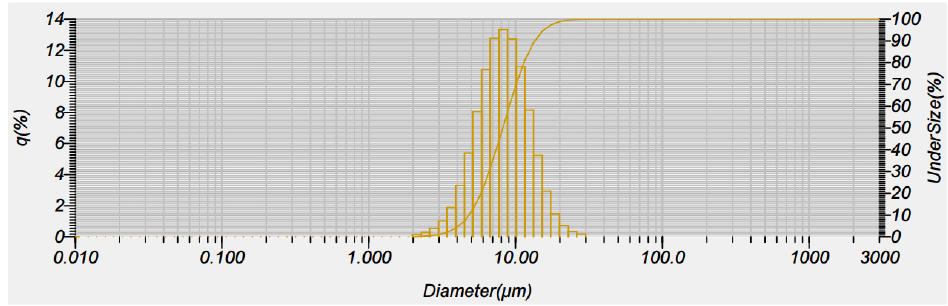
Figure 8. Curcumin nanosuspension with gum arabic as the stabilizer.